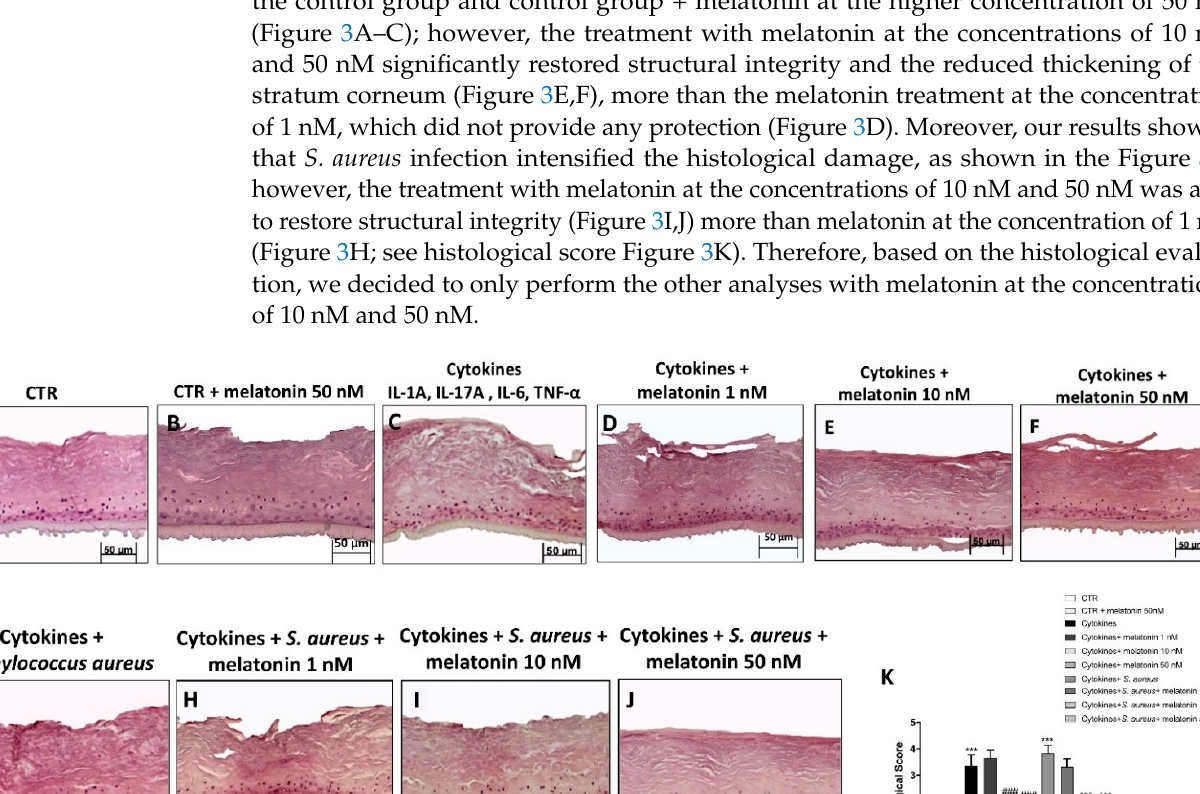
Figure 2. Effect of melatonin on CFU evaluation after S. aureus infection. The figure shows that S. aureus adherence was high in the S. aureus -associated psoriasis group compared to control (ND = not detected); however, melatonin treatment at 10 nM and 50 nM significantly reduced it. *** p < 0.001 vs. CTR; ## p < 0.01 vs. cytokines+ S. aureus group. ### p < 0.001 vs. cytokines + S. aureus group.